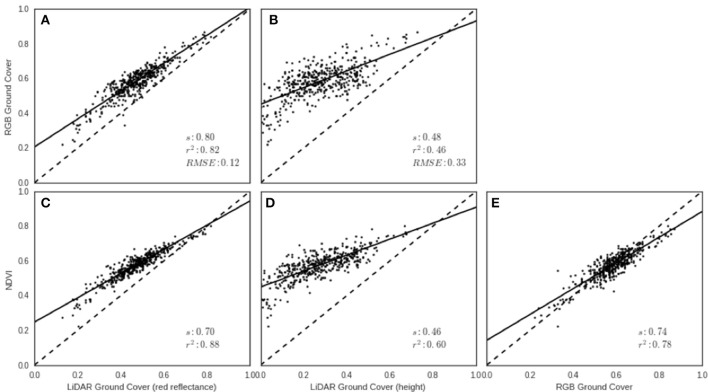
Ground cover (GC) validation from EXP2 on 13th August 2014. Relationships between LiDAR-derived GC using (A) red reflectance and (B) height with RGB-derived GC. Relationships between LiDAR-derived GC using (C) red reflectance and (D) height, with NDVI from the GreenSeeker. Relationship between (E) RGB-derived GC and NDVI from the GreenSeeker. Solid lines represent the linear regression and broken line represents 1:1.